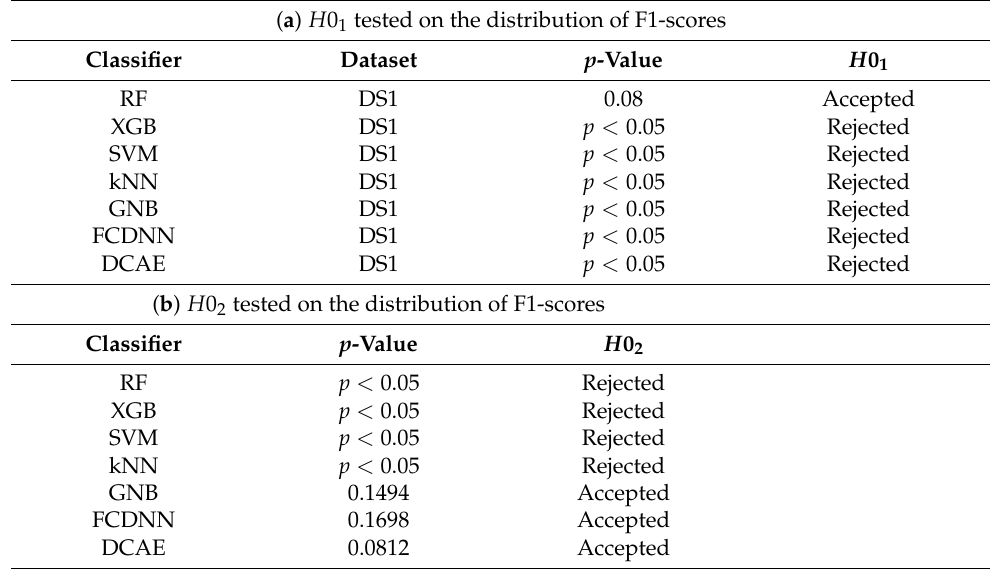
Table 4. ( a ) One-tailed Kruskal-Wallis test performed to test H 0 1 for all classifer’s F1-scores compared with F1-scores of a baseline classifier [41]. ( b ) One-tailed Kruskal-Wallis test performed to test H 0 2 on the distribution of F1-scores for each classifier for both DS1 and